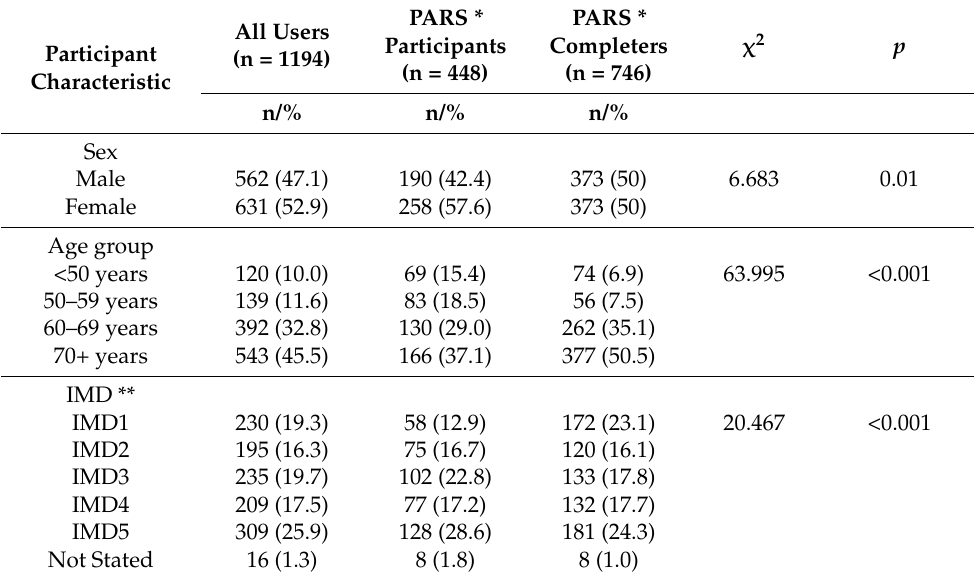
Table 1. Participant characteristics of PARS users between March 2019 and February 2020.